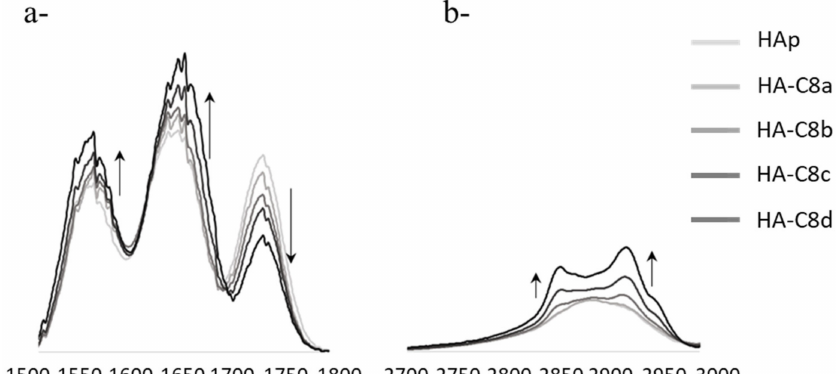
Figure 1. FTIR spectra of octylamine functionalized HA samples: ( a ) carbonyl vibrations region (1500–1800 cm − 1 ) and ( b ) C–H stretching vibrations region (2700–3000 cm − 1